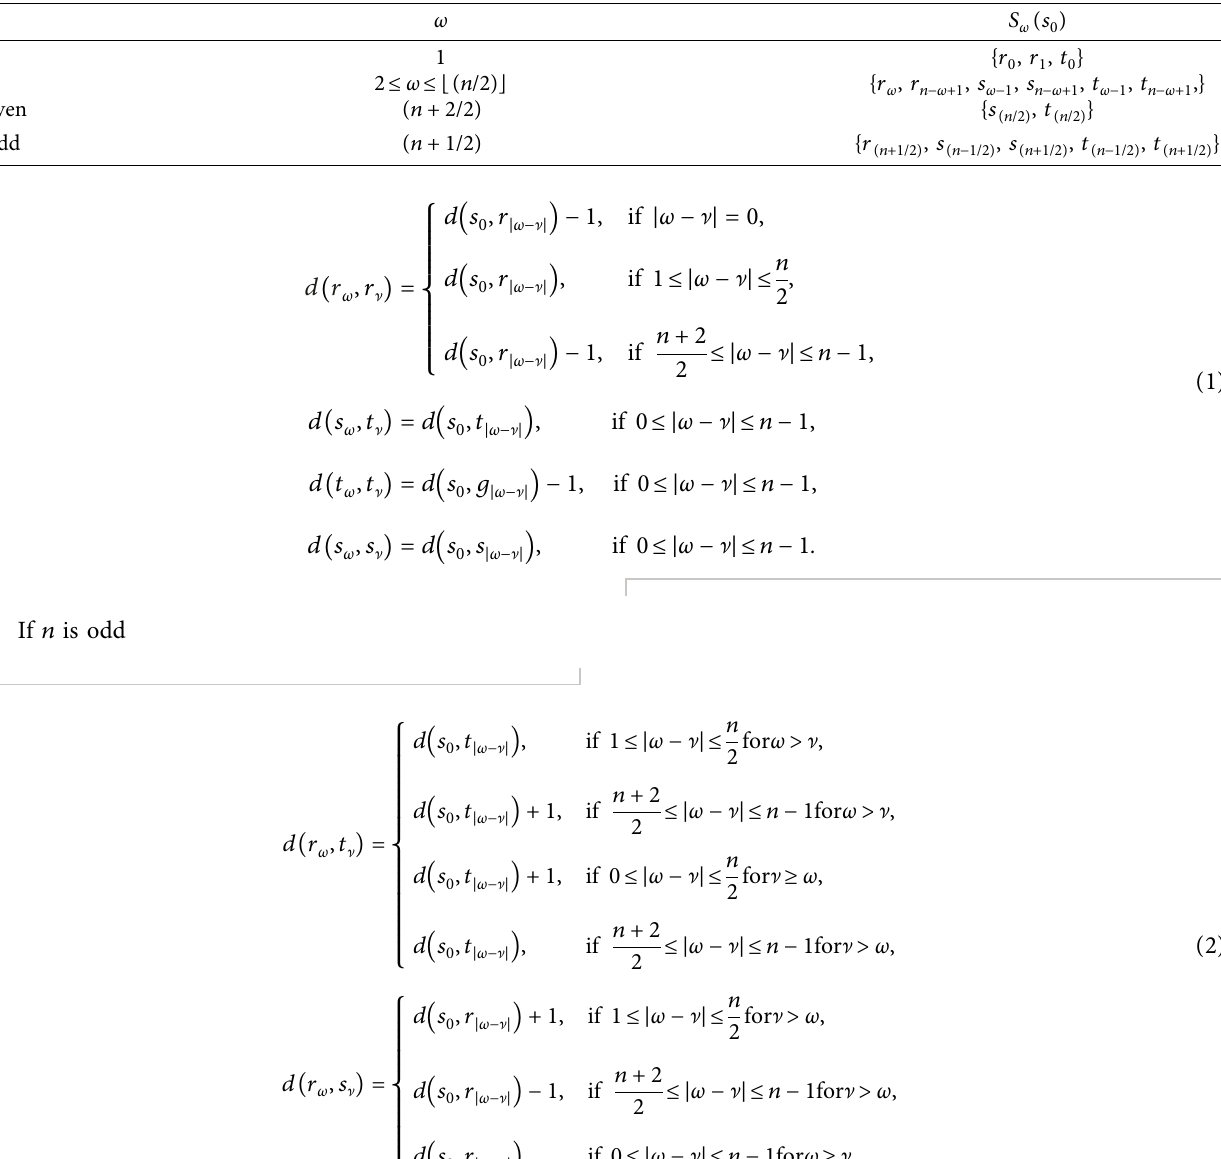
n . s T n ω ( 0 ) for